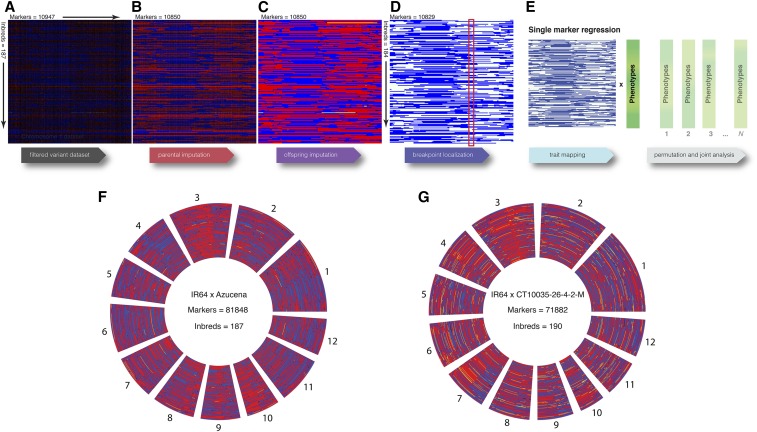
Stages of processing GBS variant data. After variant calling with GATK, variant calling data (vcf format) undergoes four stages of processing. (A–D) represent chromosome 1 of the IR64 × Azucena population, with each row representing each NAM line, and each column a marker. Red markers are homozygous for the IR64 state, blue for Azucena, yellow heterozygous, and black missing. The first stage (A) involves variant filtering with custom software described by Heffelfinger et al. (2014), (B) parental imputation and filtering with LB-Impute, and (C) offspring imputation with LB-Impute. Since LB-Impute may leave variants adjacent to transitions in parental state as missing, BP-Impute is applied in (D) to infer the most likely breakpoint location (red box). Genotypes may be left as probabilities or can have discrete genotypes assigned through least squares. BP-Impute is designed to prepare datasets for joint trait mapping and genetic map construction; NAM lines with excessive heterozygosity are also removed. In (E) phenotypes are regressed on each marker, then permuted phenotypes are also used to calculate locus-specific P values. The locus-specific P values can be used in joint analysis. (F) and (G) represent the entire LB-Impute dataset for the IR64 × Azucena and IR64 × CT10035-26-4-2-M NAMs, with each concentric circle depicting a separate NAM genome. For (G), blue is the homozygous CT10035-26-4-2-M state. GBS, genotype-by-sequencing; NAM, Nested Association Mapping.